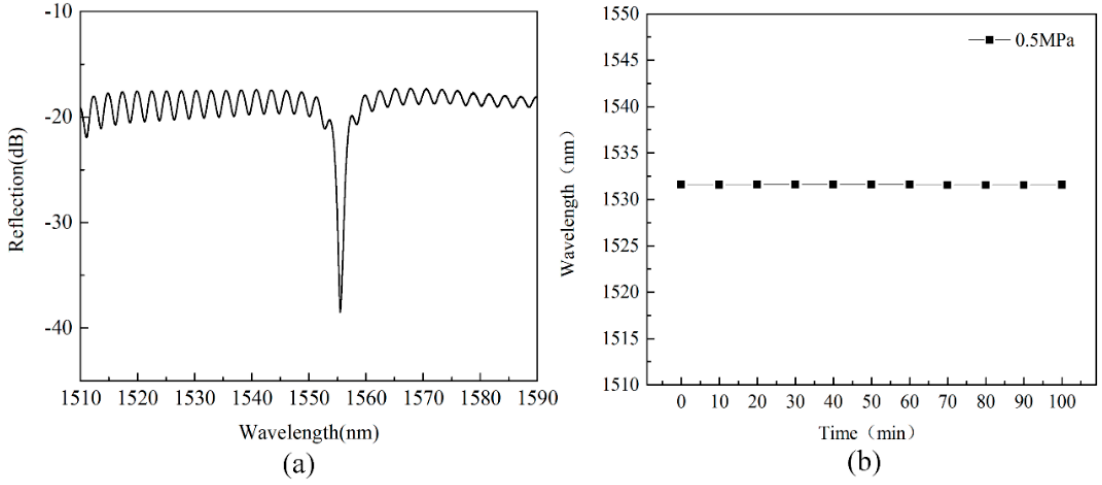
Figure 7. The output of the fiber-optic Fabry–Perot pressure sensor: ( a ) the multi-beam spectrum of the sensor at room temperature, and ( b ) the wavelength of the spike under 0.5 MPa constant pressure. In order to verify the repeatability of the sensor, the pressure of sensor#1 was boosted from 0 MPa to 0.5 MPa, with a step size of 0.05 MPa, and then the pressure was released back to approximately 0 MPa three times. The measured wavelength is shown in Figure 8. It can be observed that there is a small difference in sensitivity, which may be affected by the different vacuum environments. During three pressure tests, the regression coefficient( R 2 ) between the pressure of the sensor and the corresponding wavelength is greater than 0.99.